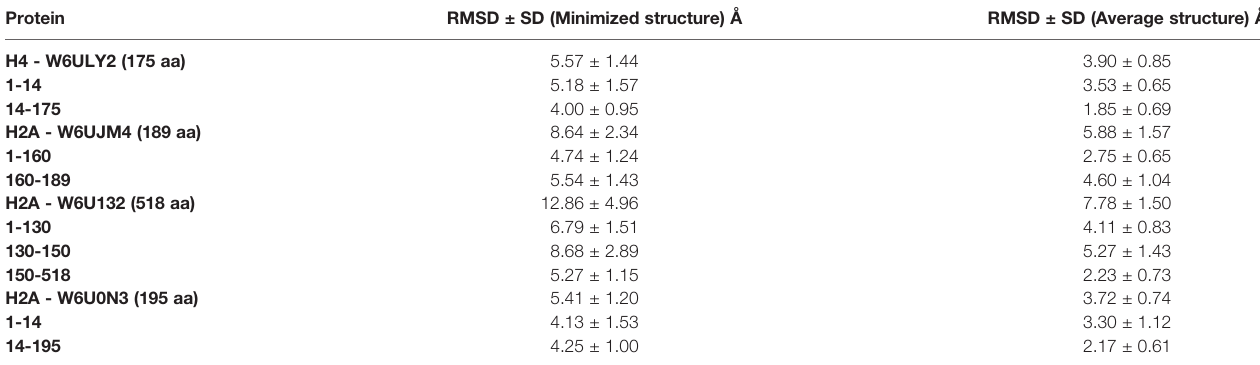
TABLE 5 | Histones RMSD for the total protein and the regions.